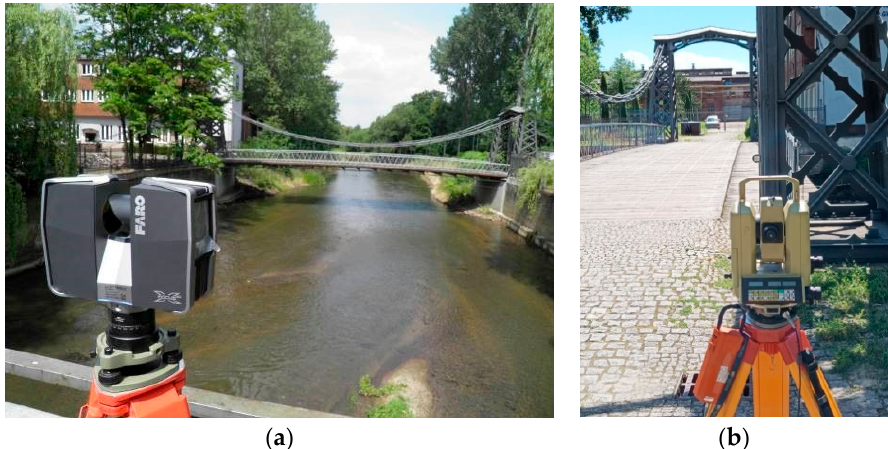
Figure 2. Measurement stations with applied instruments. ( a ) FARO Focus 130 3D laser scanner (situated on the parallel bridge); ( b ) Leica TC2002 total station.